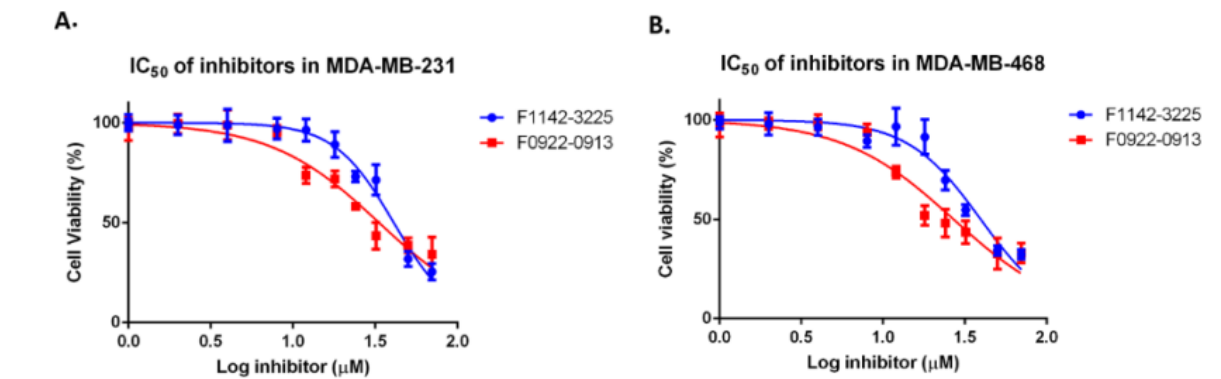
Figure 1. The IC50 plots of F1142-3225 and F0922-0913 on cell proliferation of MDA-MB-231 and MDA-MB-468 . Cell proliferation after treatment of MDA-MB-231 ( A ) or MDA-MB-468 cells ( B ), with F1142-3225 or F0922-0913 for 4 days. Cell proliferation was determined by cell proliferation reagent WST-1. Data are reported as the mean ± SD ( n = 3) of the individual experiments. The experiment was independently repeated three times.